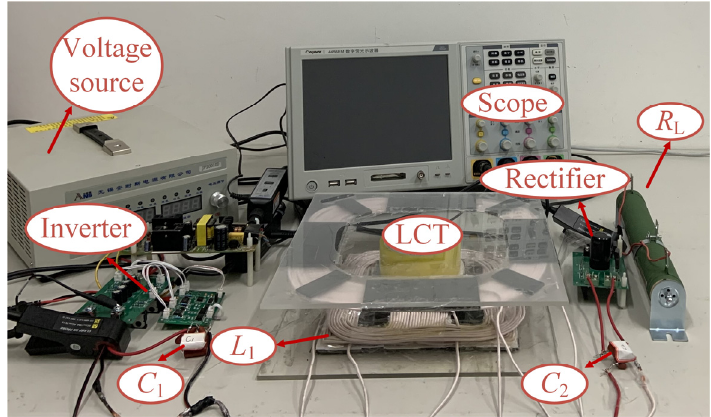
Figure 11. Experimental setup of the proposed LC/S compensated IPT system.